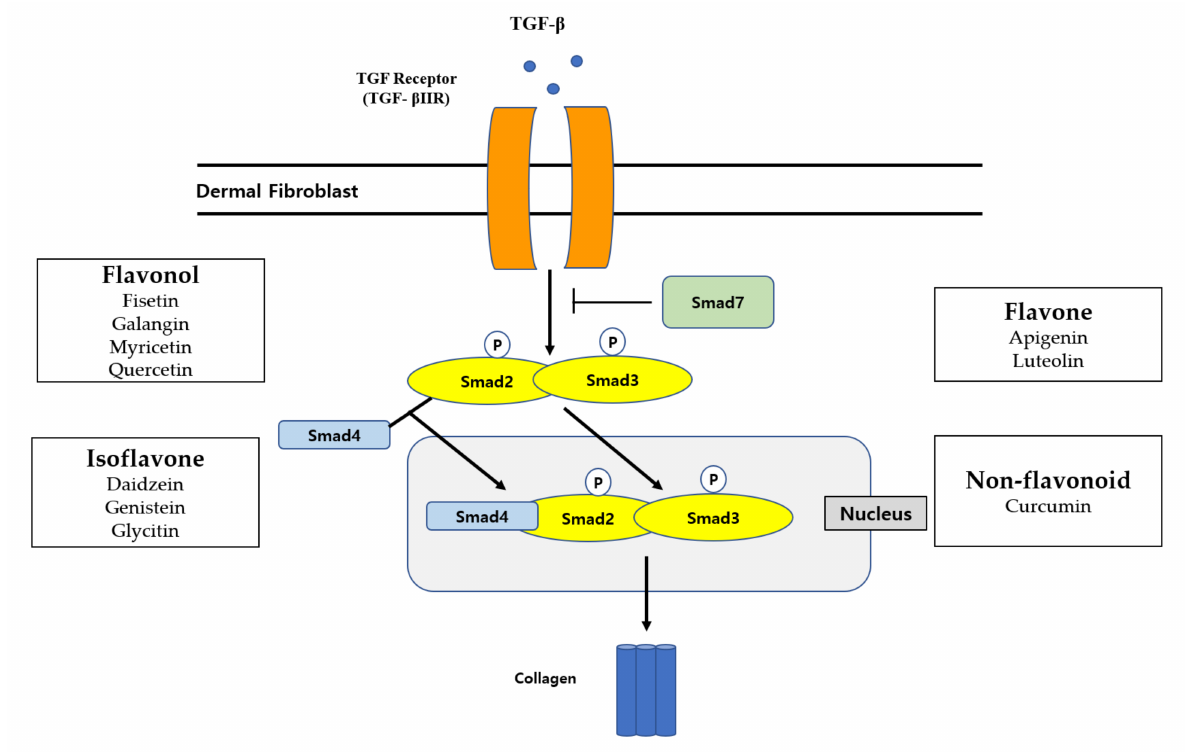
Figure 2. Diagram of TGF β -mediated Smad2/3 signaling pathway and polyphenols in aged der- mal